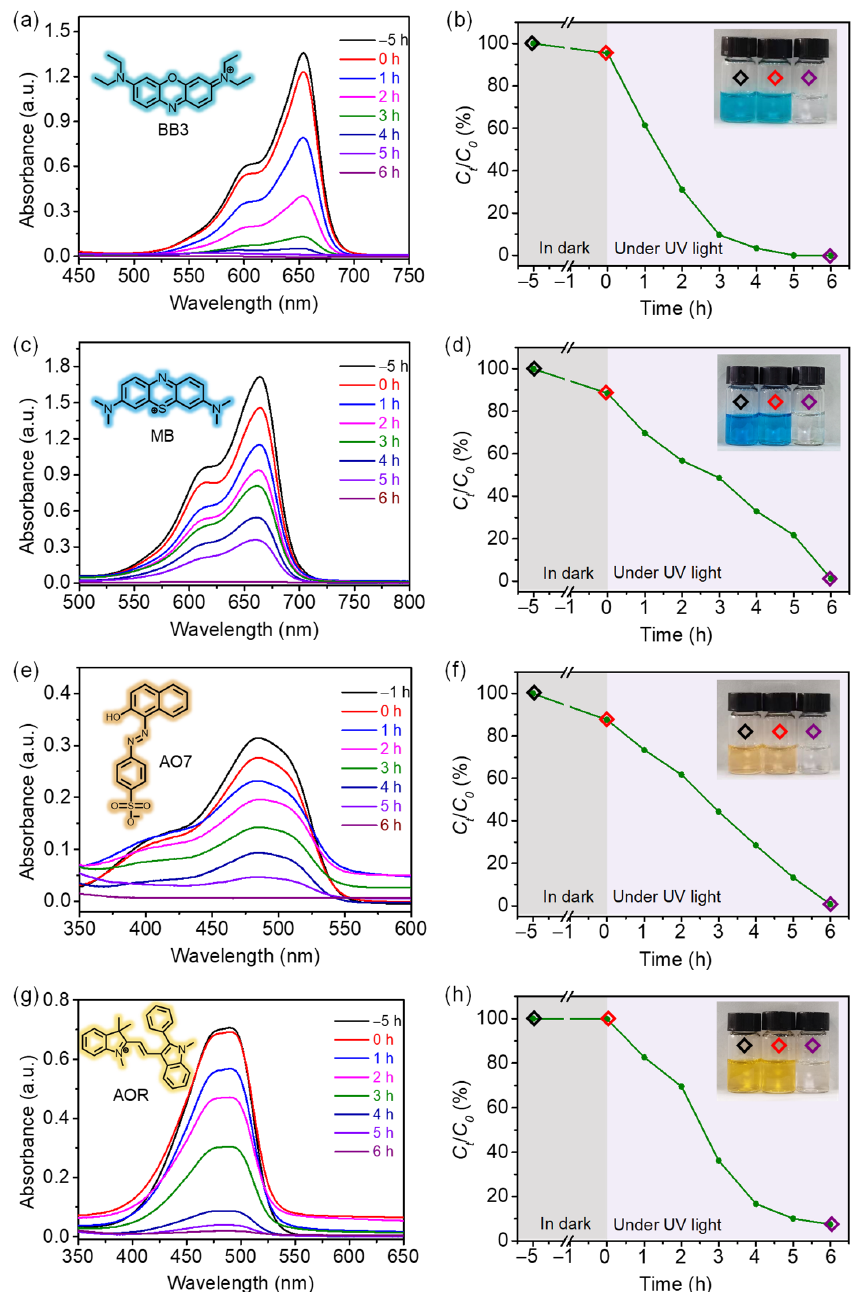
Figure 4. Reaction time-dependent UV–vis absorption spectra and concentration variations of ( a , b ) BB3, ( c , d ) MB, ( e , f ) AO7, and ( g , h ) AOR with the presence of COF-300 (Inset shows the photographs of the dye solutions. Black: blank; red: 5 h in dark; purple: 6 h under UV light irradiation).